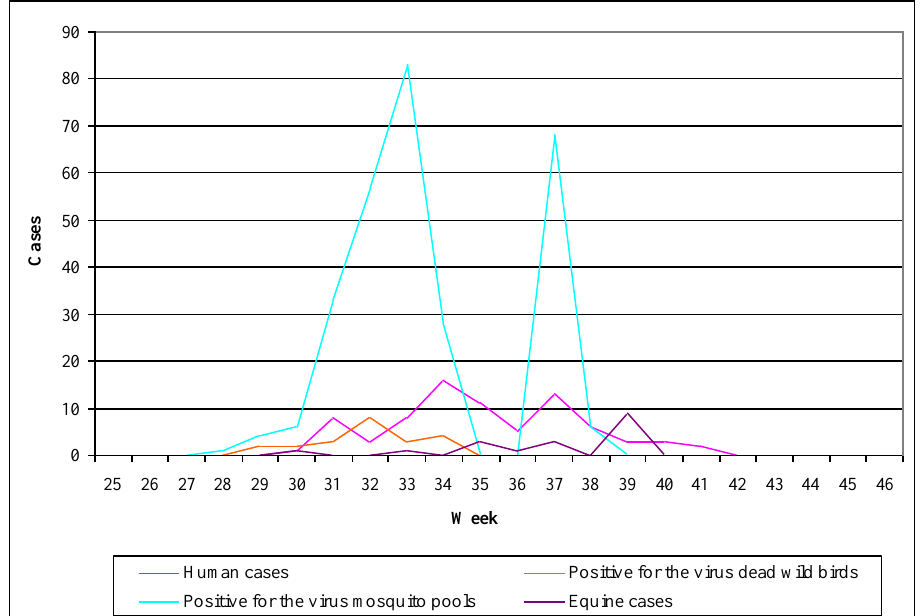
Figure 12. Weekly surveillance data from Canada,